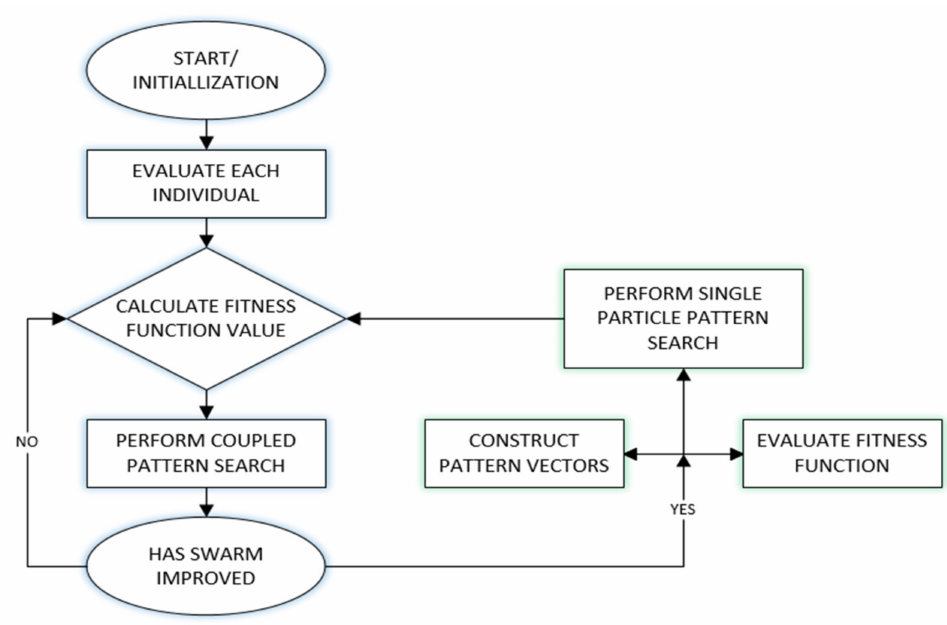
Figure 5. Schematics of the Hybrid Optimizer/ Particle Swarm Optimization (PSO) algorithm combined with the Pattern Search